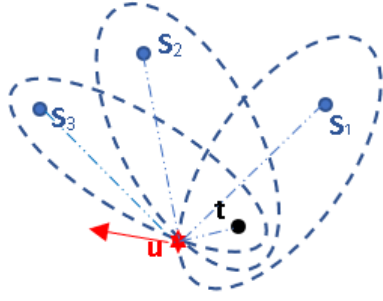
Figure 1. The elliptic scenario in the existence of 3